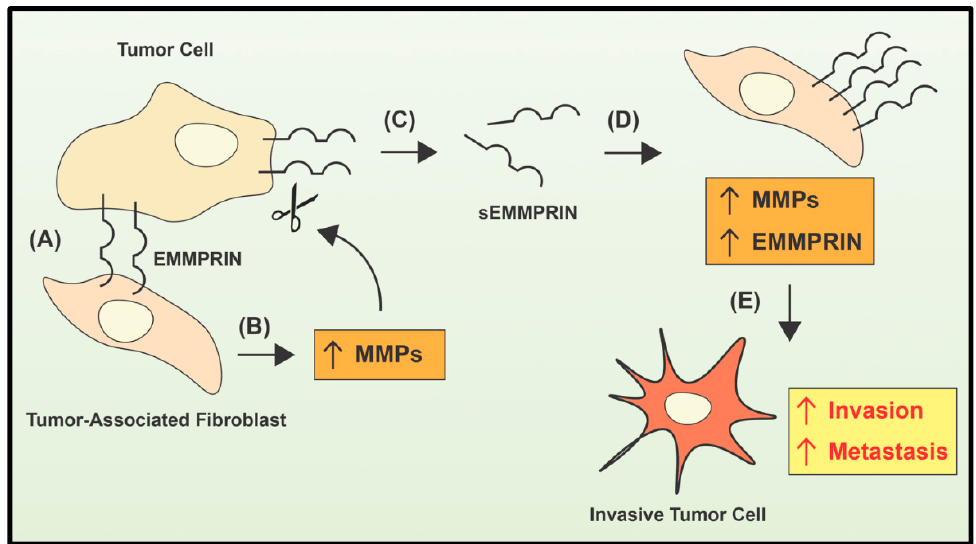
Figure 1. Interplay between EMMPRIN and MMP leads to metastasis. Soluble EMMPRIN (sEMMPRIN) and membrane-bound EMMPRIN form a bidirectional feedback between tumor cells and stromal cells. ( A ) Plasma membrane bound-EMMPRIN of the tumor cells interacts with cancer-associated stromal cells, such as fibroblasts. ( B ) This interaction between the cell-types induces up-regulation of MMP expression and secretion by the fibroblasts. ( C ) The MMPs secreted by fibroblasts cleave membrane-bound EMMPRIN to generate sEMMPRIN. ( D ) sEMMPRIN further augments MMP and EMMPRIN expression either in fibroblasts in the local tumor microenvironment or at distal sites. ( E ) This process then stimulates cancer cell invasion and metastasis. Modified from [56].